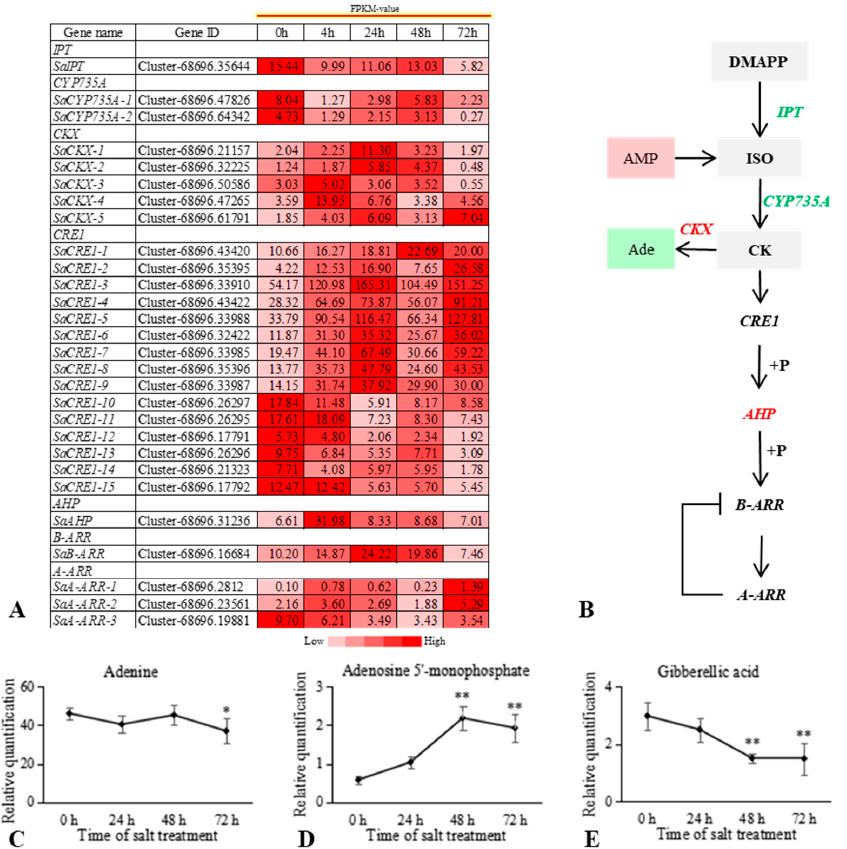
Figure 5. Overview of the relationship between differentially expressed genes (DEGs) and differential metabolites (DMs) in the CK signaling pathway of S. alopecuroides under salt stress. ( A ) Heat map of CK signaling pathway-related gene expression. Values are average FPKM values of each sample in each group. ( B ) Overview of CK signaling pathway. ( C – E ) The trend in CK and gibberellin (GA) signaling pathway DM changes with salt stress. The horizontal axis represents the duration of salt treatment, and the vertical axis represents the relative quantification of metabolites (peak area × 10 6 ). Expression levels of six independent samples of metabolites and the control were compared by t -test, where ** represents p < 0.01 and * represents p < 0.05. Expression scores are shown as fold-change. Ade, adenine; CRE1, Arabidopsis histidine kinase 2/3/4 (cytokinin receptor); AHP, histidine-containing phosphotransfer protein; ARR-A, two-component response regulator ARR-A family; ARR-B, two- component response regulator ARR-B family; CKs, cytokinins; CKX, cytokinin dehydrogenase; CYP735A, cytokinin trans-hydroxylase; ISO, isopentenyl; IPT, cystathionine